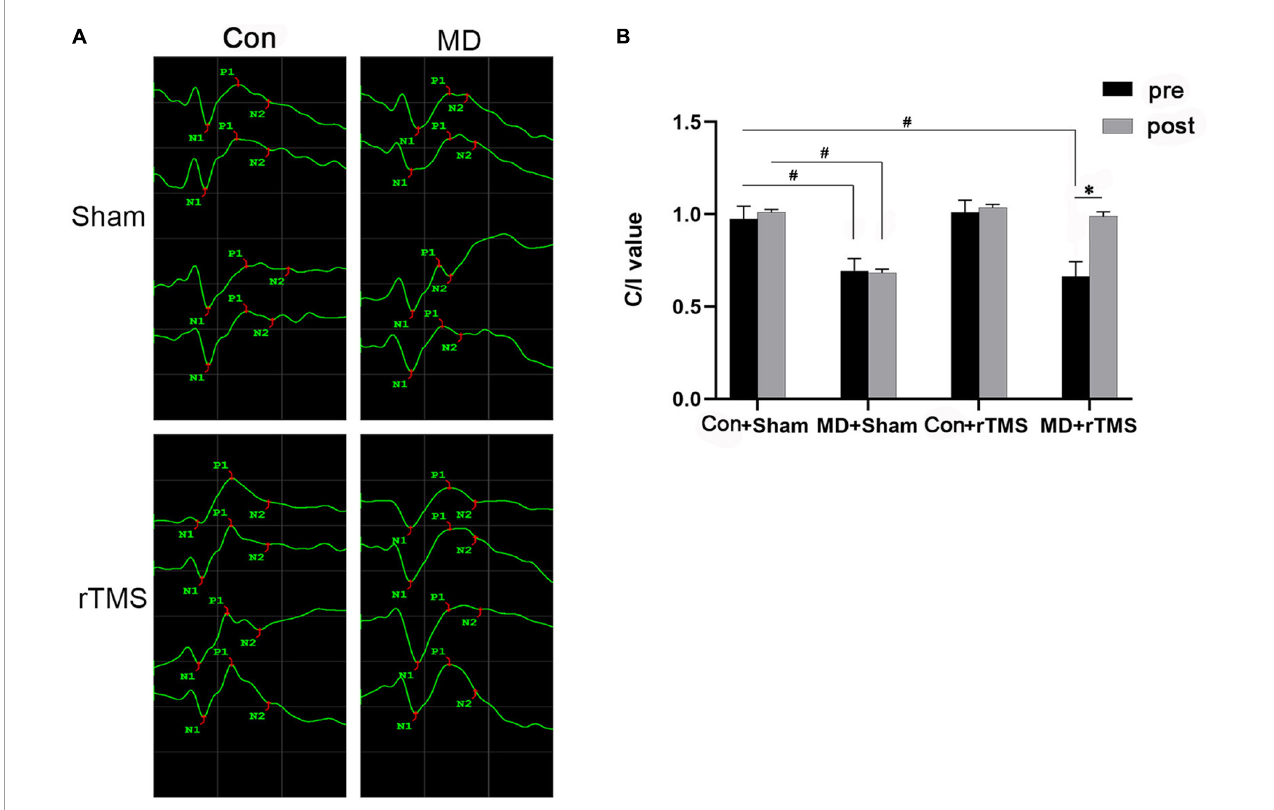
FIGURE2 Flash visual evoked potentials (fVEP) before and after treatment in each group. (A) The fVEP waveform changes before and after intervention in the four groups. The waveforms from top to bottom in the Con groups were right eye, right eye after intervention, left eye, and left eye after intervention. In monocular deprivation (MD) groups, the waveforms from top to bottom were deprived eye, deprived eye after intervention, non-deprived eye, and non-deprived eye after intervention. (B) P1-wave amplitude of fVEP in each group was analyzed before and after intervention, and the data are presented as contralateral vs. ipsilateral value (C/I) value, as assessed by repeated-measures analysis of variance (ANOVA) with Bonferroni’s correction. Following repetitive transcranial magnetic stimulation (rTMS), the C/I value of amblyopic rats improved significantly compared to the previous data. No improvement was observed in amblyopic rats exposed to sham stimulation. Data are expressed as mean ± standard error of the mean (SEM). # denotes significant comparison among MD and Con+Sham group, p < 0.001; ∗ indicates significant difference between MD+rTMS pre and after rTMS, p <